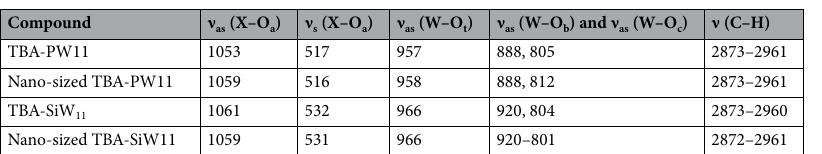
Table 1. Representation of important absorption bands (cm −1 ) for TBA-PW 11 and TBA-SiW 11 heterogeneous and nano